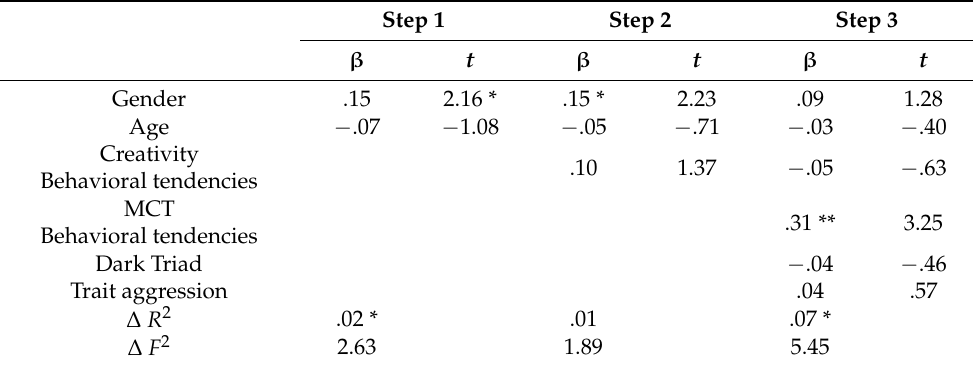
Table 2. Results of hierarchical regression analysis using gender (0 = female, 1 = male), age, and the other scale scores as independent variables on MCT originality.